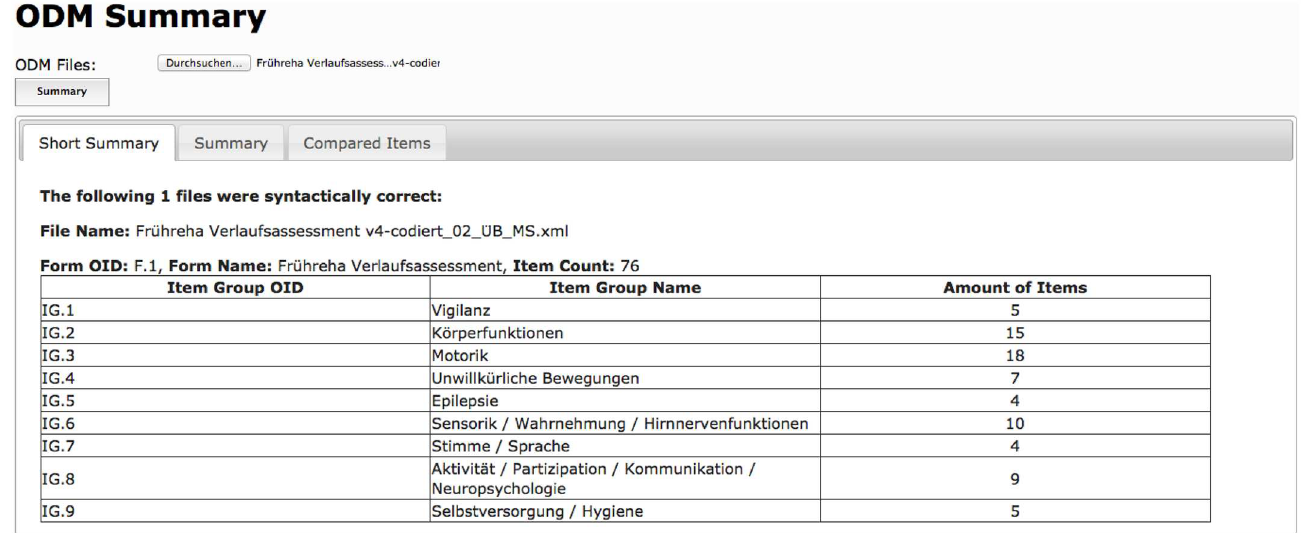
Fig 5. Short summary of a forms’ content. Item groups and amount of items are presented for each input file.